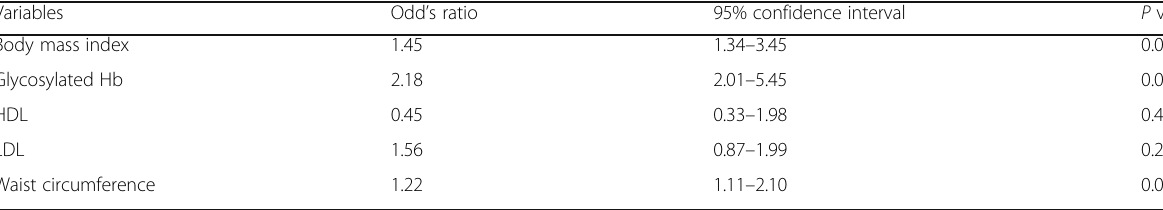
Table 4 Multivariate regression analysis for prediction of aortic stiffness Variables Odd ’ s ratio 95% confidence interval Body mass index